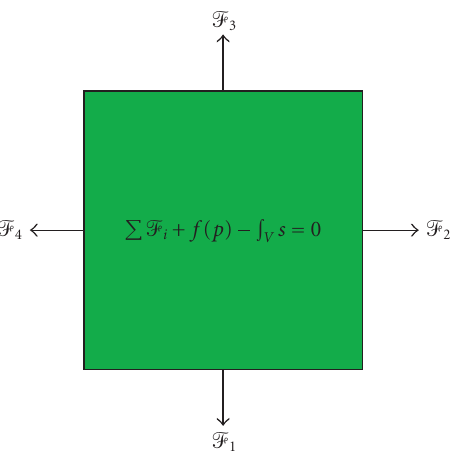
Figure 2.1 . A nonlinear discrete equation for a finite volume. Here, (cid:2) i with i = 1, ... ,4 are the fluxes through the cell